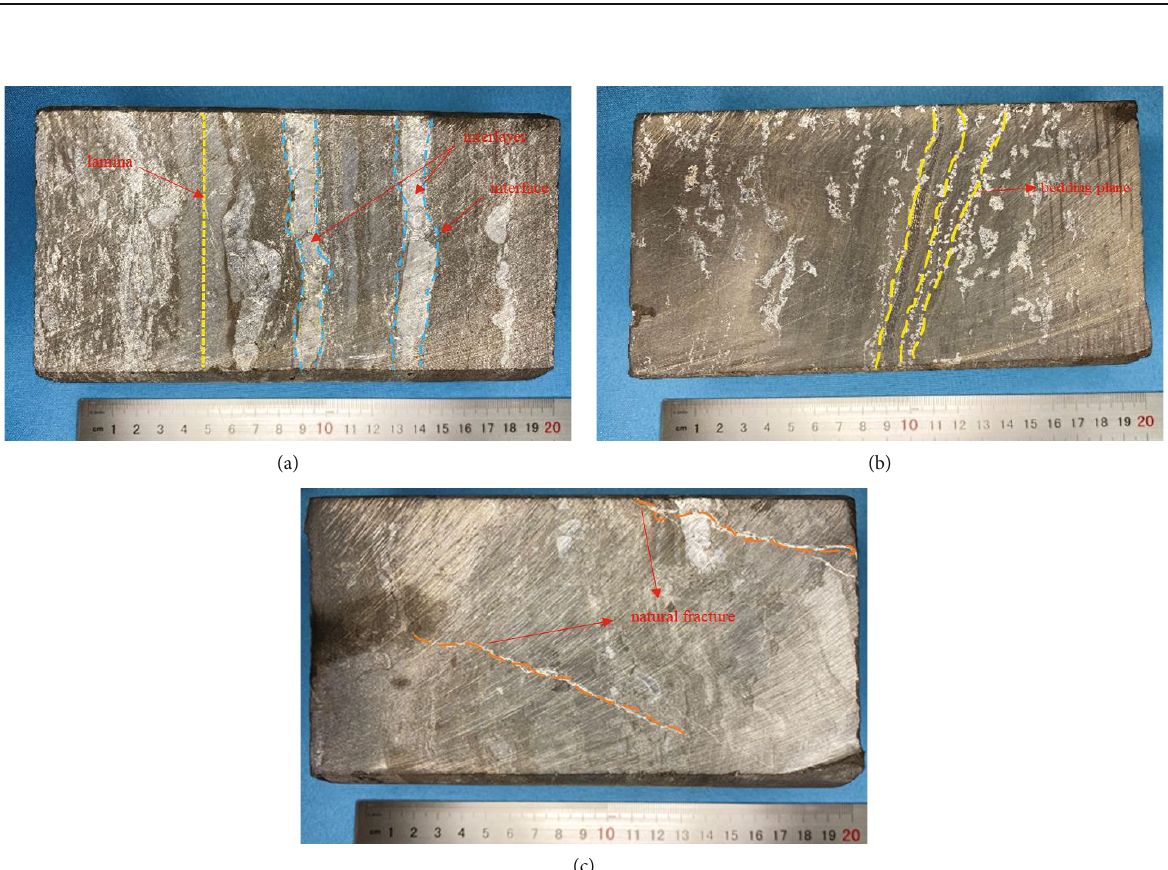
Figure 1: Di ff erent cores of Permian Fengcheng Formation in Well Maye X1. (a) Core with laminas. (b) Core with beddings. (c) Core with three natural